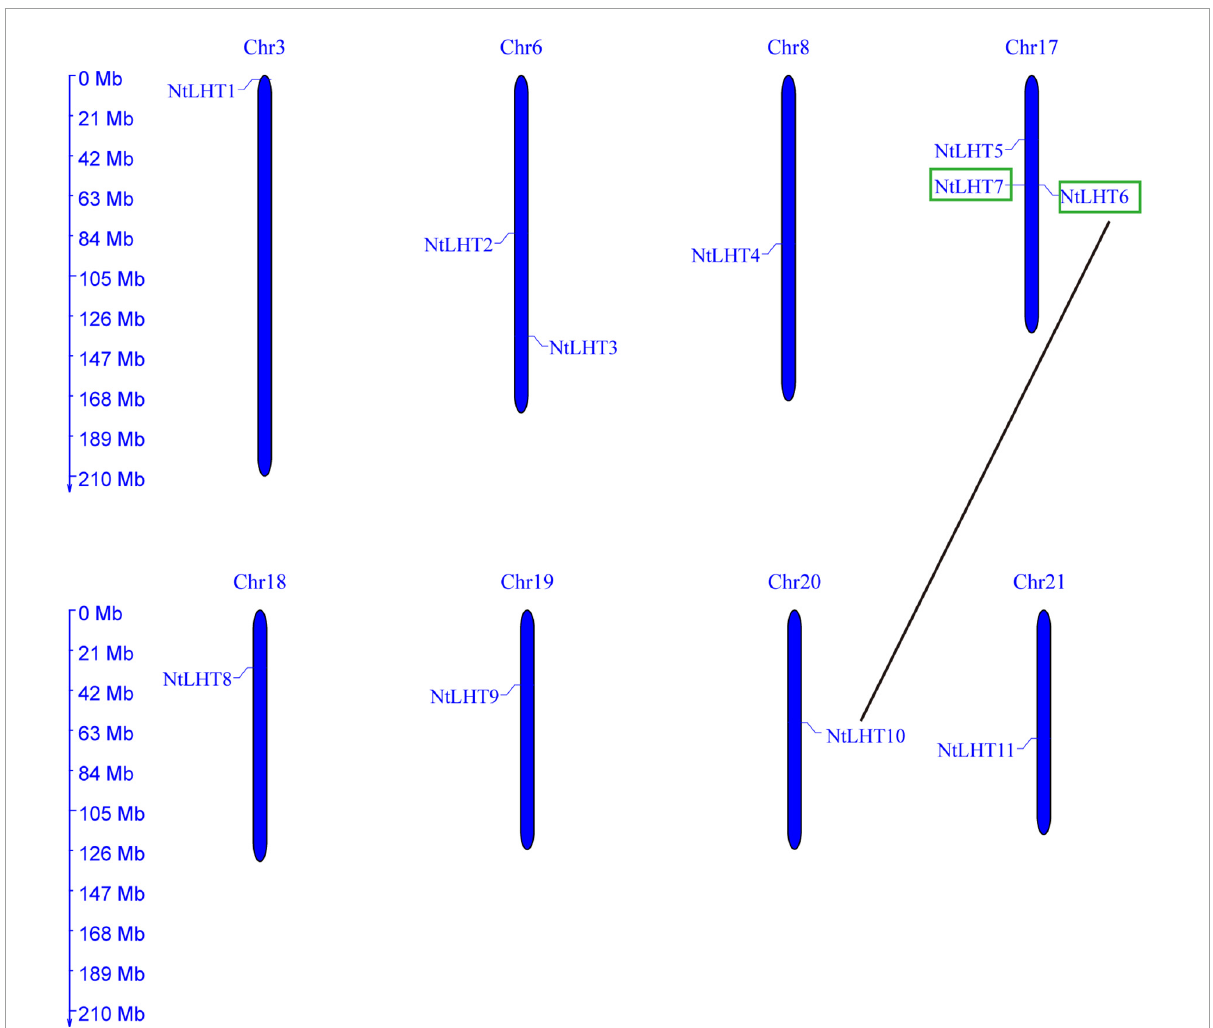
FIGURE3 Chromosomal locations and duplication of NtLHT genes. Segmental duplication of NtLHT genes are connected by black line and green box shows tandem duplicated gene